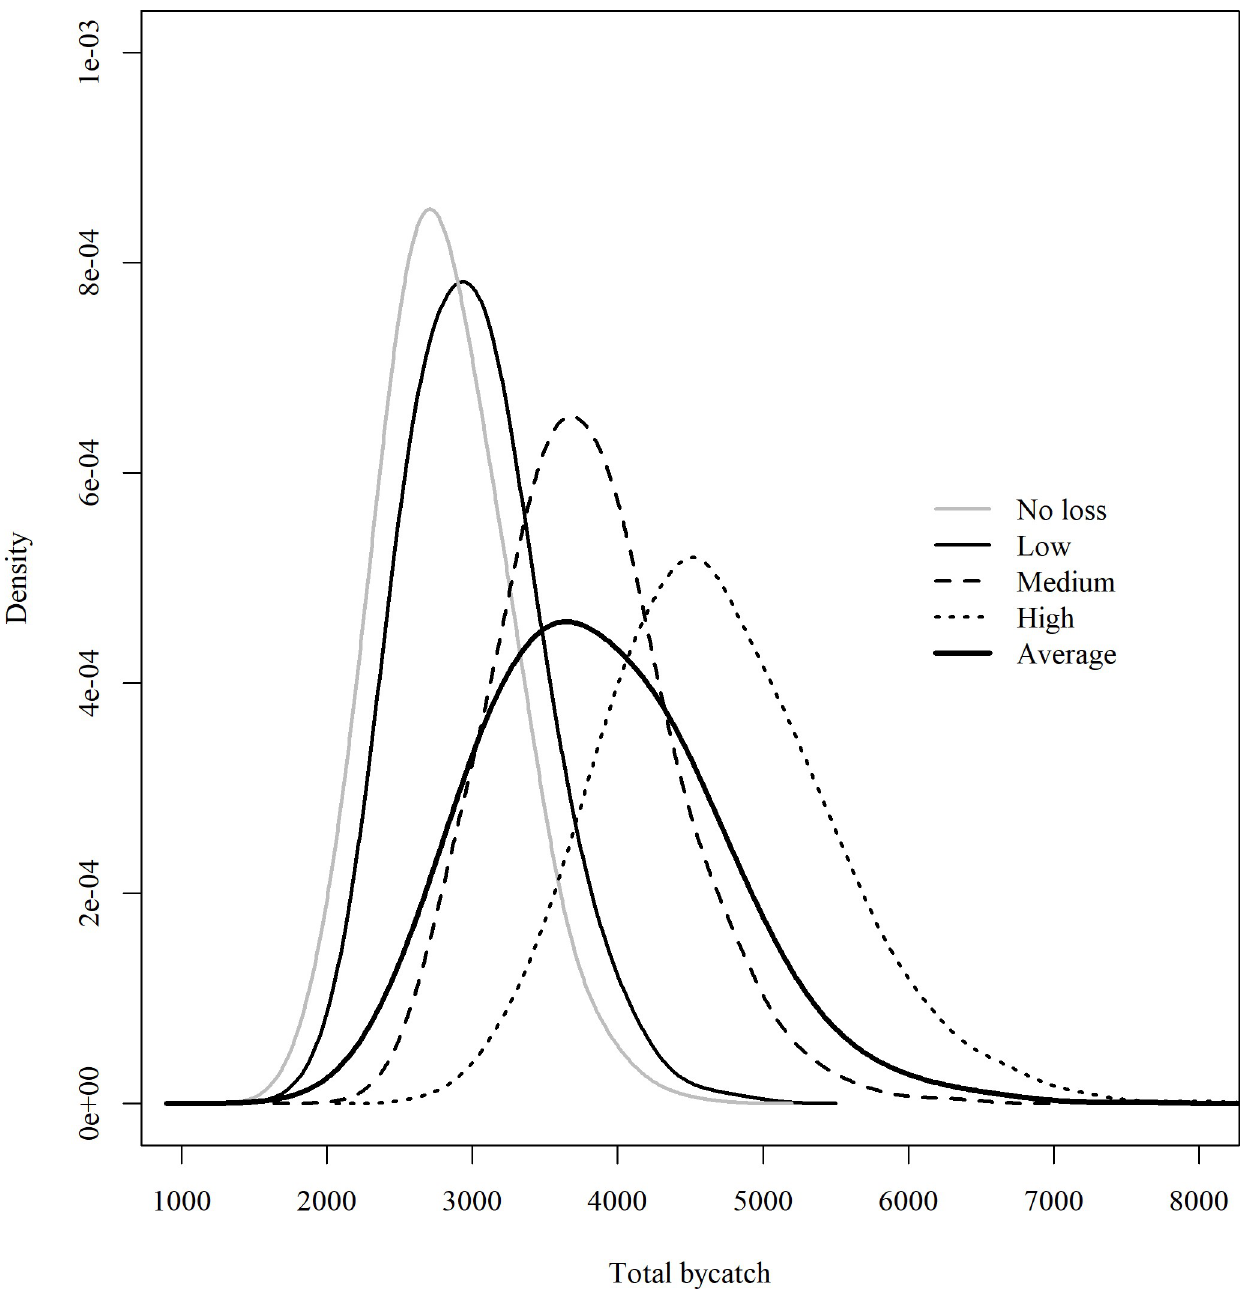
Fig 6. Estimated total seabird bycatch from 1992 to 2016 by the U.S. Atlantic PLL fleet. Estimates of total seabird bycatch were generated for four bycatch loss scenarios and a loss-free model.